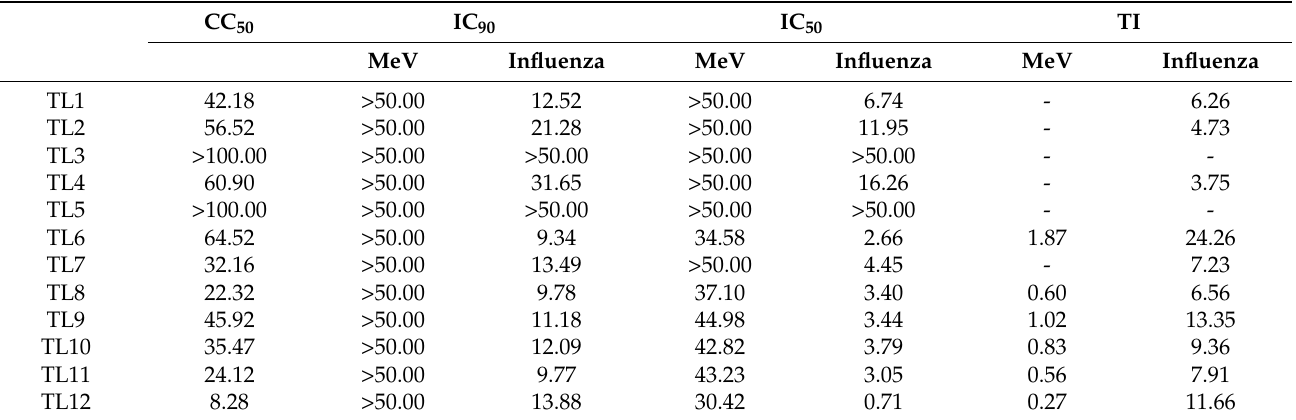
Table 4. CC 50 , IC 90 , IC 50 and TI calculated for measles (MeV) and influenza viruses. Concentrations are expressed in µ